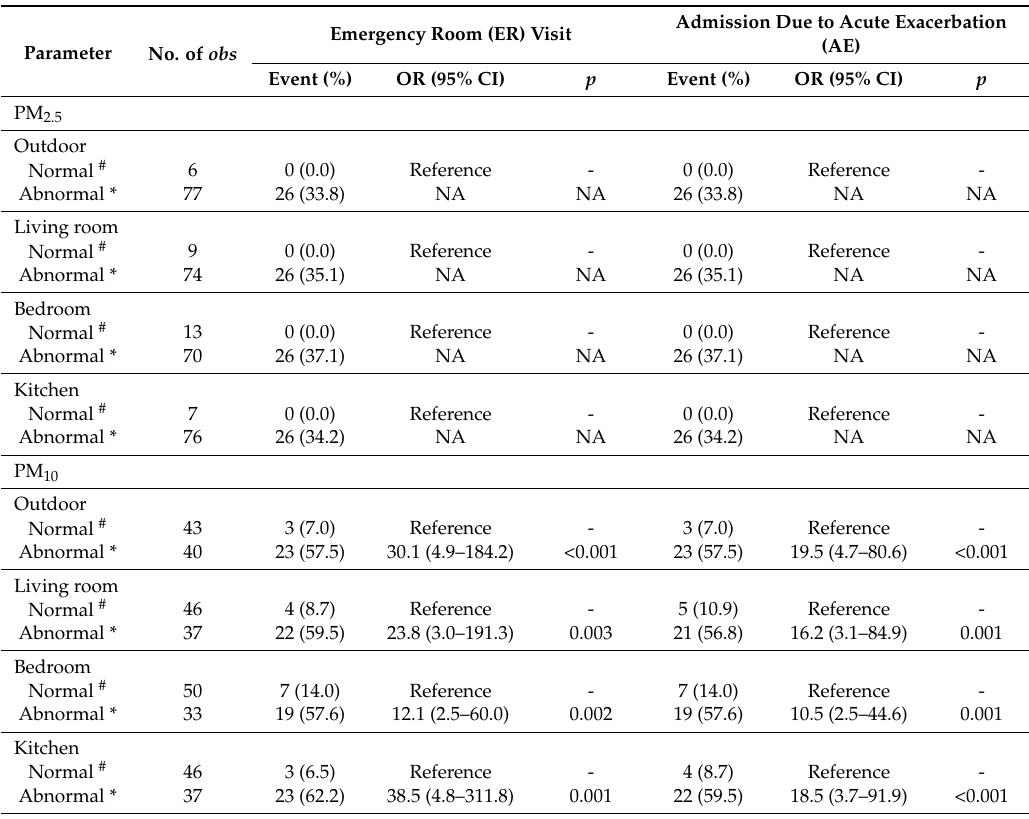
Table 4. Association between particulate matter (PM 2.5 and PM 10 ) and acute exacerbation in COPD